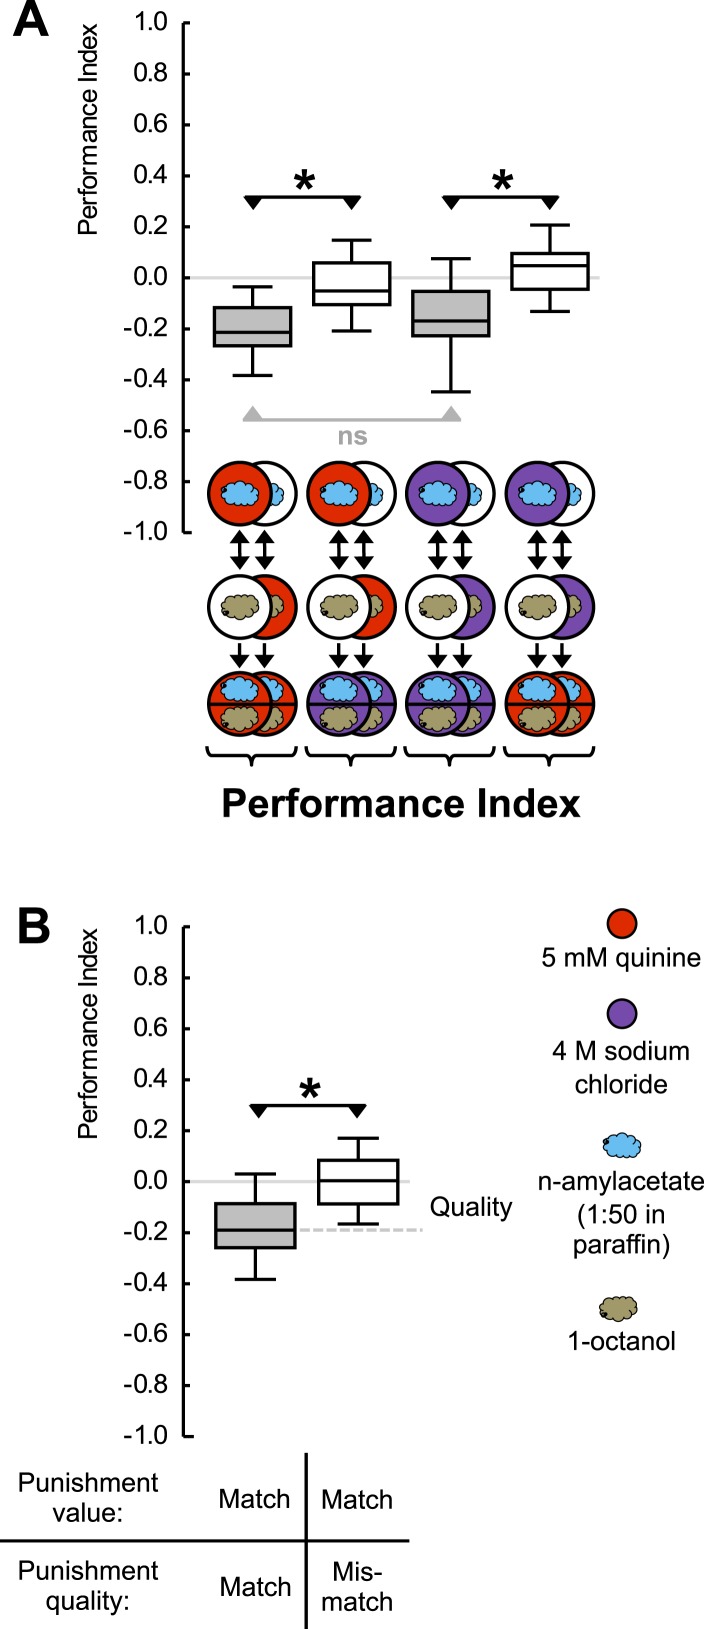
Punishment processing by quality.(A) Larvae are trained to associate one of two odors with either 5 mM quinine (red circle) or 4 M sodium chloride (purple circle) as punishment and asked for their choice between the two odors—in the presence of either substrate. The larvae show learned escape from the punishment-associated odor only if a matching quality of punishment is present during the test as compared to training. (B) Data from (A) combined according to ‘Match’ or ‘Mismatch’ between test- and training-punishment. We note that value-memory would reveal itself by negative scores upon a match of punishment value despite a mismatch in punishment quality, which is not observed (right-hand box plot, based on second and fourth box plot from A). Sample sizes: 25–32. Shaded boxes indicate p < 0.05/4 (A) or p < 0.05/2 (B) from chance (one-sample sign-tests), asterisks indicate pairwise differences between groups at p < 0.05/3 (A) or p < 0.05 (B) (Mann–Whitney U-tests). For a detailed description of the sketches, see legend of Figure 1.